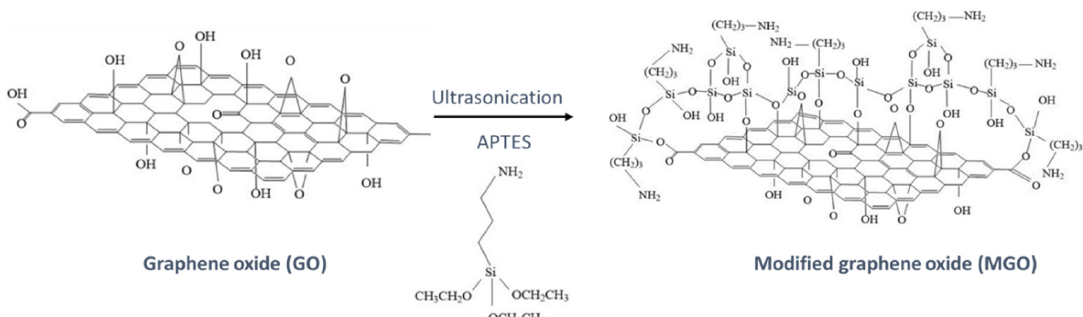
Figure 14. Fabrication of modified graphene oxide through ultrasonication assisted by silanization (adapted from [47]).